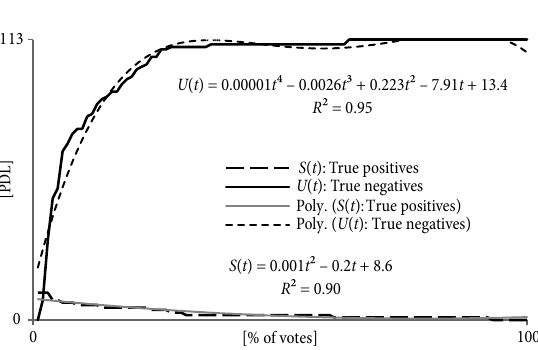
Fig. 5. Optimisation made using equalizing of frequencies of hits